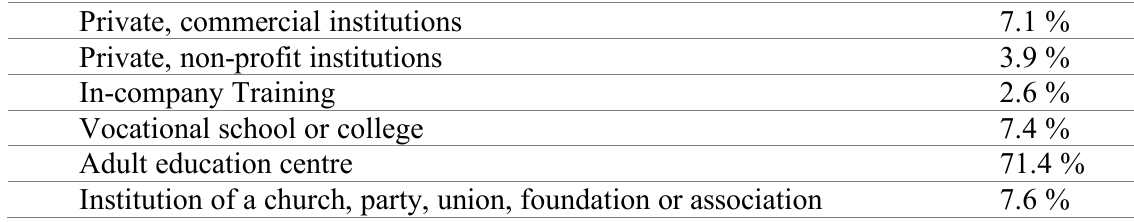
Table 2: Institutions in which adult educators taught predominantly in the present sample (n =